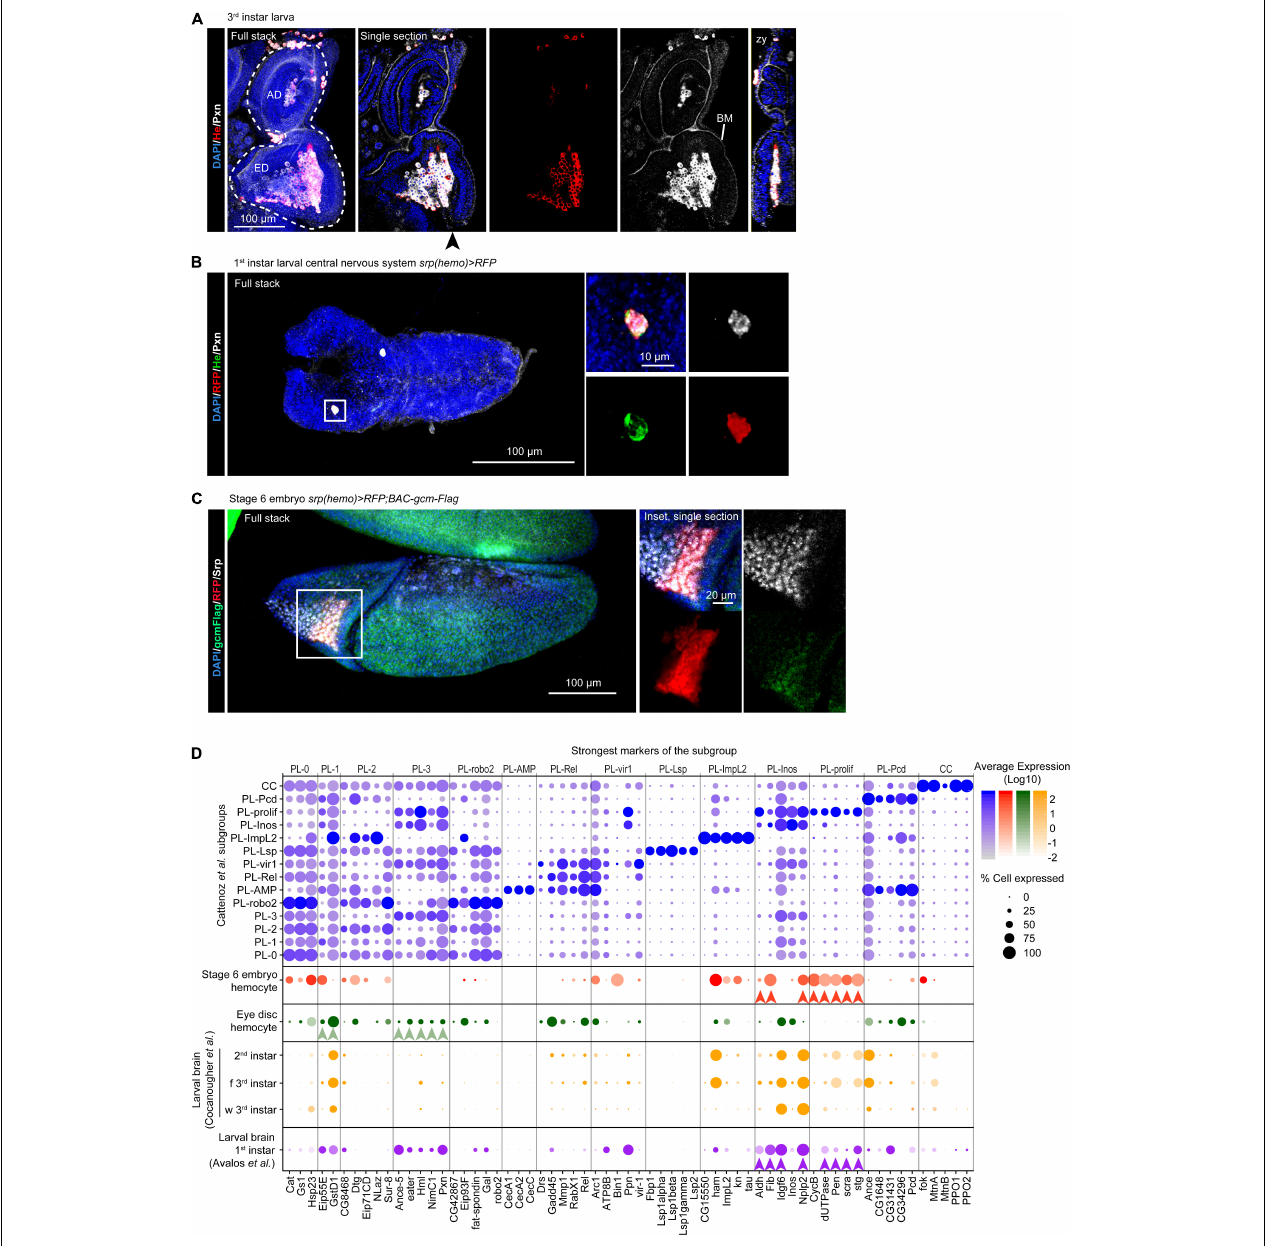
FIGURE 4 | The molecular signatures of the hemocytes from larval eye discs, larval brains and stage 6 embryos. (A) Eye disc from 3rd instar larva. The immunolabelling assay used anti-He (in red), anti-Pxn (in white) and the nuclei were labeled with DAPI (blue). The left panel shows the full stack, the eye disc (ED) and the antenna disc (AD) are indicated with a white dashed line, the next panels show a single section with all the channels, He labeling only and Pxn labeling only, respectively. Pxn labeling is present at the basement membrane (BM). The rightmost panel shows an orthogonal projection along the z-y axes from the position indicated by the black arrowhead. The scale bar represents 100 µ m. (B) Central Nervous System from 1st instar larva carrying the srp(hemo) > RFP transgene, which allows for hemocyte detection (Gyoergy et al., 2018). The immunolabelling assay used three hemocyte markers [anti-RFP (in red), anti-He (in green), anti-Pxn (in gray)], and the nuclei were labeled with DAPI (blue). The left panel shows the full stack, the right panels (partial stacks) show the inset at high magnification (merged and individual channels). The scale bars represent 100 µ m in the full stack and 10 µ m in the inset. The hemocyte lays on the surface of the nervous system. (C) Stage 6 embryo srp(hemo) > RFP; BAC-gcm-Flag . The BAC was used to reveal the Gcm protein (Laneve et al., 2013). The immunolabelling assay used anti-RFP (in red), anti-Flag (in green), anti-Srp (in gray), and the nuclei were labeled with DAPI (blue). The left panel shows the full stack, the right panels show a single section of the inset at high magnification (merged and individual channels). The scale bars represent 100 µ m in the stack and 20 µ m in the inset. (D) Dot plot representing the expression levels and percentage of cells expressing the top markers of each subgroup identified by Cattenoz et al. (2020). The violet dots represent the expression in Cattenoz et al. (2020) subgroups, the red dots, expression in the hemocytes from stage 6 embryos (E6 embryos), the green dots in the hemocytes from larval eye discs, the purple and orange dots in the hemocytes from larval brains at the indicated stages (f 3rd instar: feeding 3rd instar larvae; w 3rd instar: wandering 3rd instar larvae). The arrowheads (red, green, purple) indicate the strongest markers linking the tissue-specific hemocytes with the subgroups from Cattenoz et al. (2020).